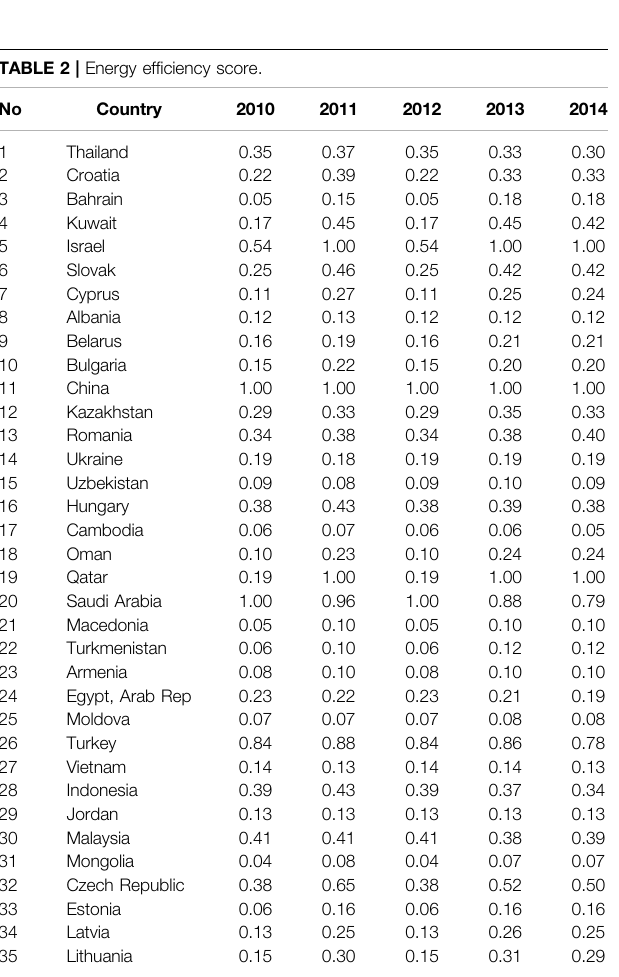
FIGURE 2 | Regional energy ef fi ciency score.